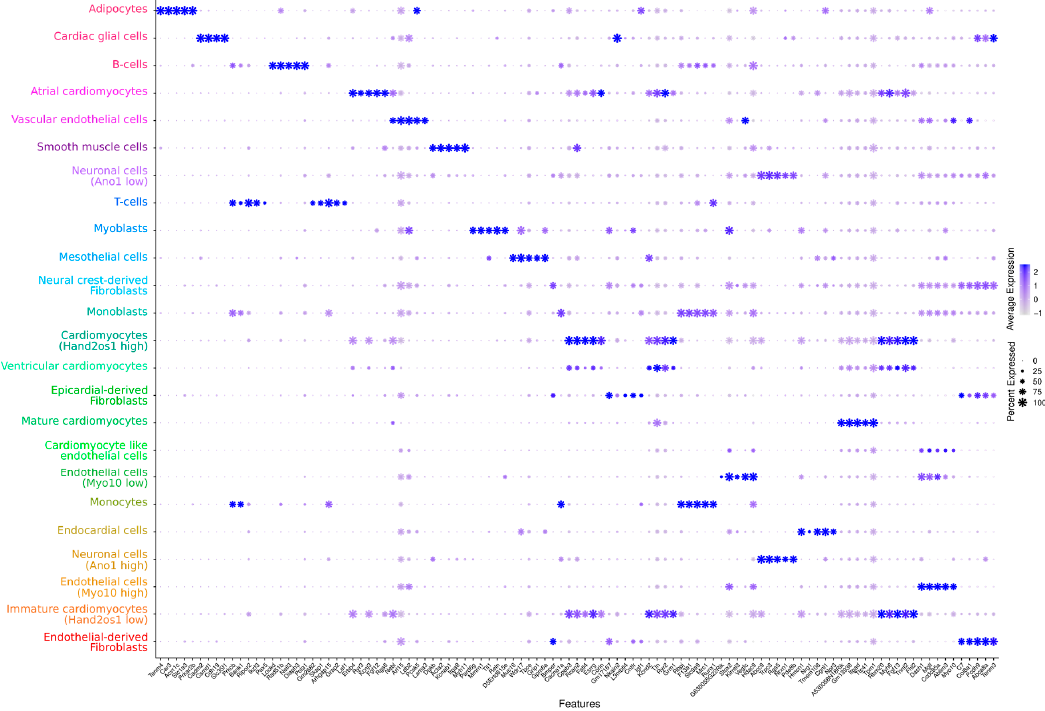
Figure 2. Dot-plot representation of the gene expression marker genes for the identified cell types. The size of dots represents the relative gene expression in percent for each cluster, e.g., a value of 100 means that each cell within this cell type expressed this gene. The color indicates the average expression level for the indicated gene per cell type. The color of the clusters is taken from Figure 1. A dot plot for the most significant gene per cluster as well as an extended visualization of the top 10 markers per cluster can be obtained at our FairdomHub/iRhythmics instance.